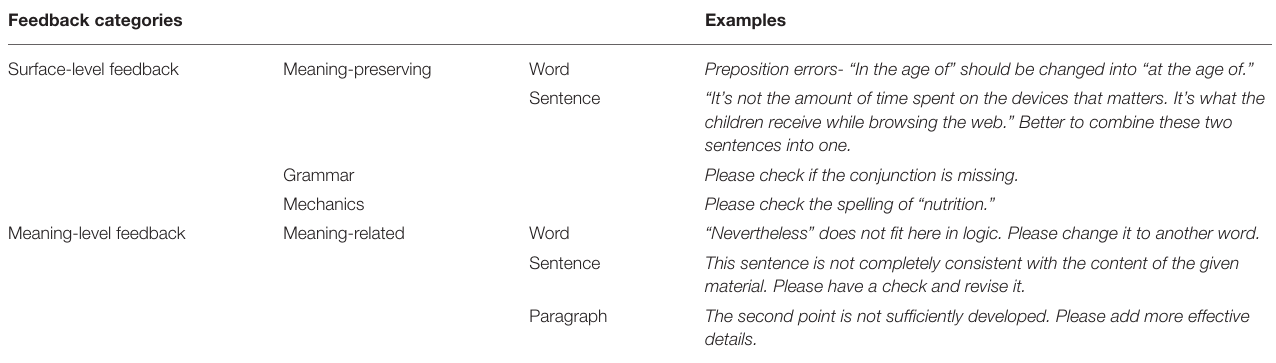
TABLE 2 | Coding scheme for feedback